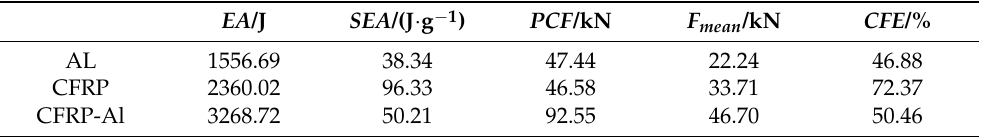
Table 5. Evaluation indexes of energy absorption characteristics for the three types of circular tubes.